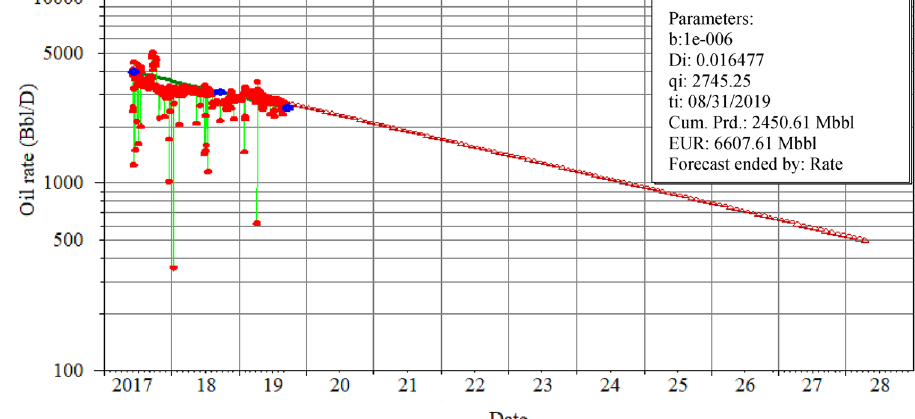
Fig. 10 Rate versus time DCA for candidate W011